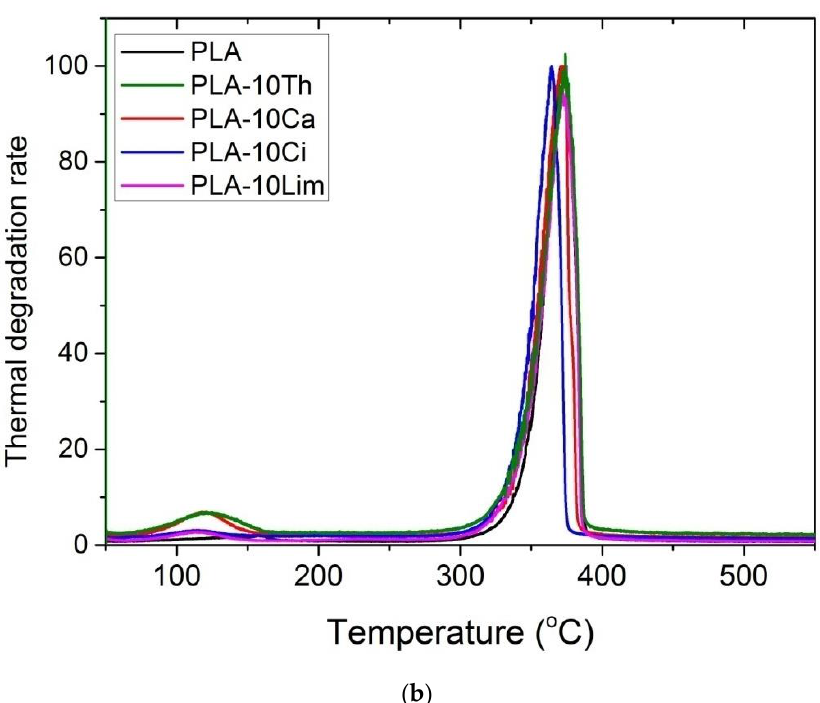
Figure 8. Thermal degradation under an inert atmosphere of PLA and its composites with a single additive ( a ) or ternary or quaternary composites ( b ) obtained from a pyrolizer using the EGA method.